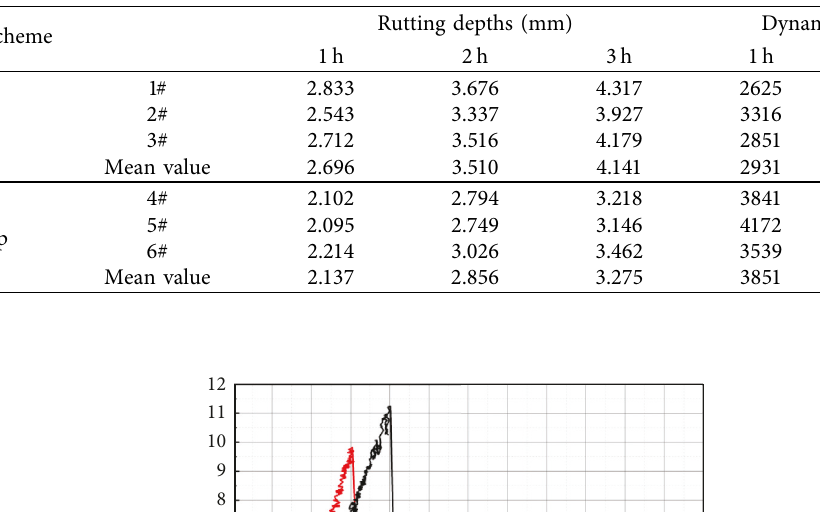
Table 8: Rutting results under different load times for two test groups.